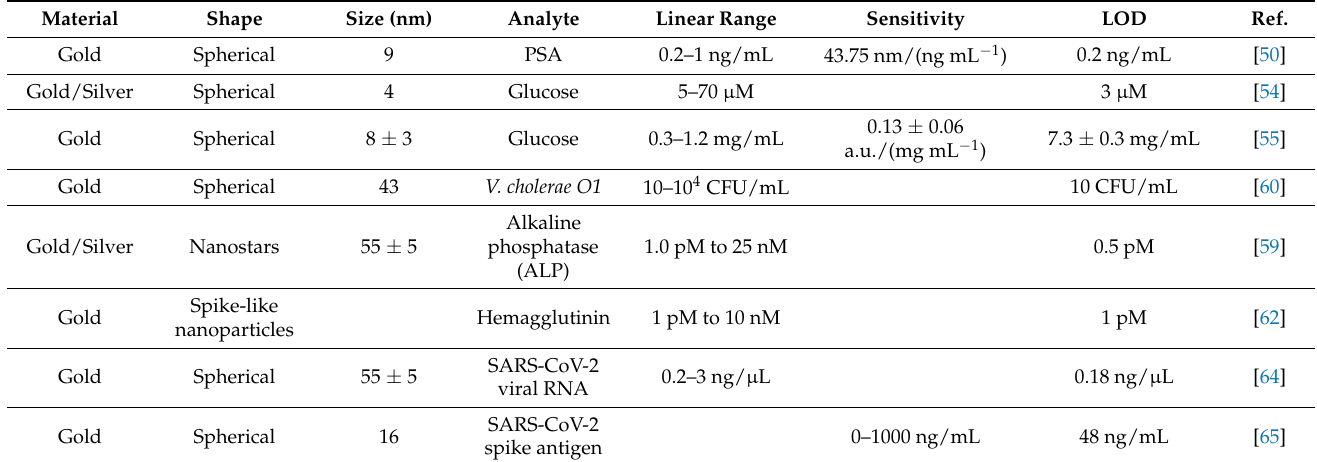
Table 1. Examples of LSPR-based colorimetric